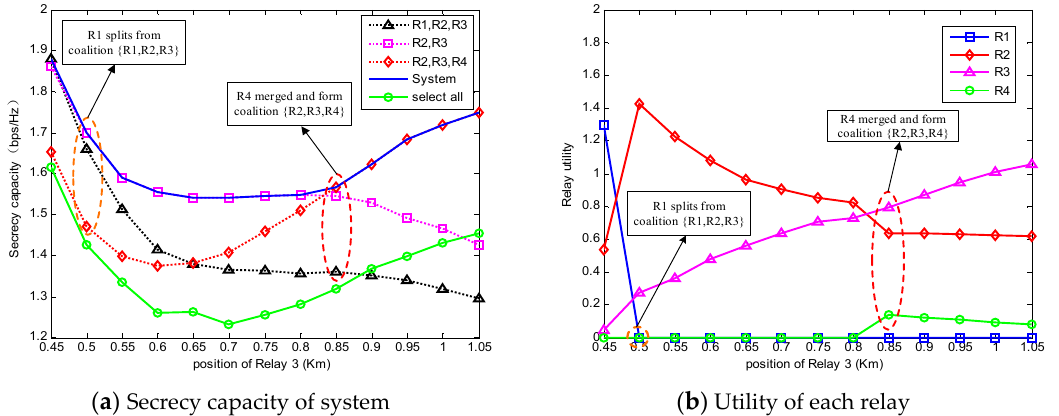
Figure 4. System secrecy capacity and the relay utilities with the movement of Relay 3 corresponding to Figure 3.